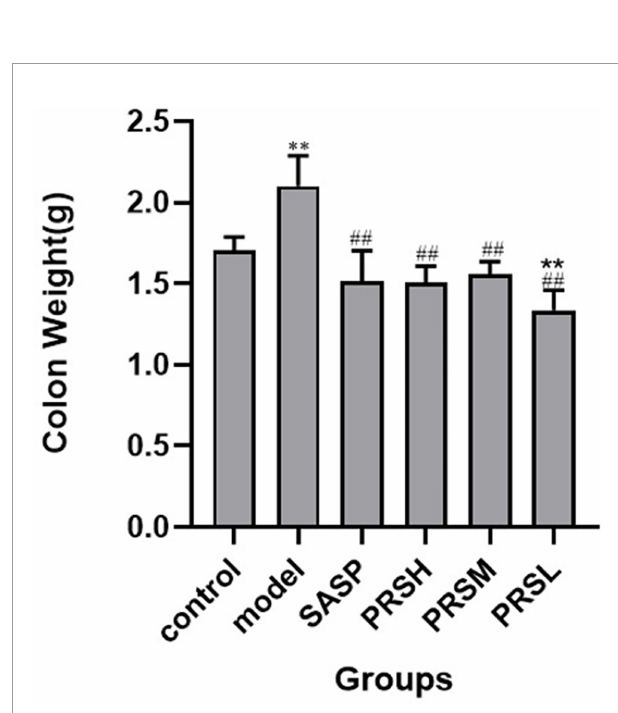
FIGURE 4 | Weight of colons from each group of rat. Data are presented as means ± SD (n= 6 per group). # p < 0.05 and ## p < 0.01 vs the model group on the same day; *p < 0.05 and **p < 0.01 vs the control